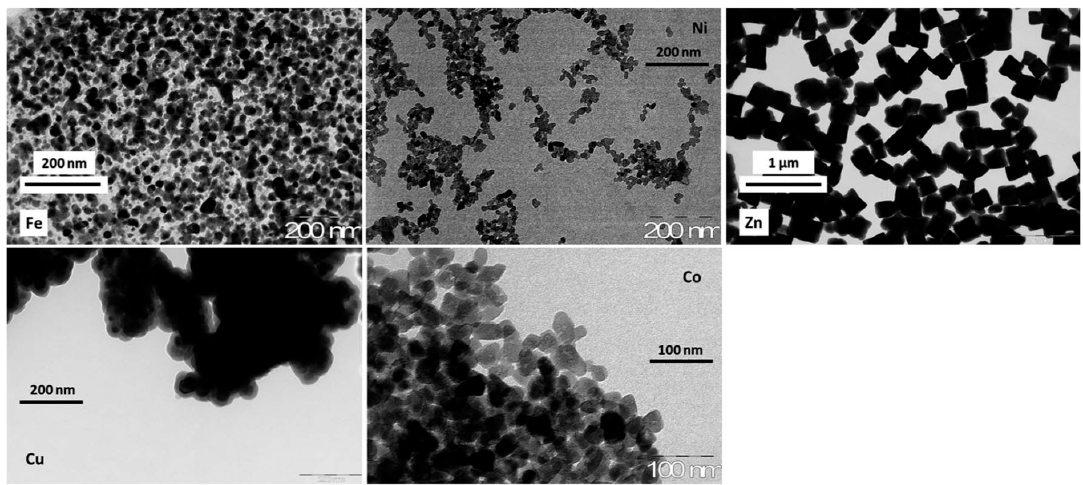
Figure 2. TEM photographs of bulk particles of metal hexacyanoferrates (reprinted with permission from Royal Society of Chemistry [18]).